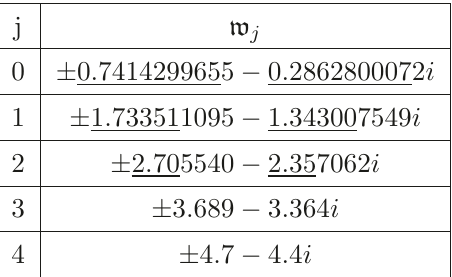
Table 3 . QNMs in sound channel of AdS 5 -Schwarzschild black brane at momentum q = 1. Full results are computed using the KI approach, only showing converged digits. Underlined digits are what is visible at the same numerical accuracy using the KS